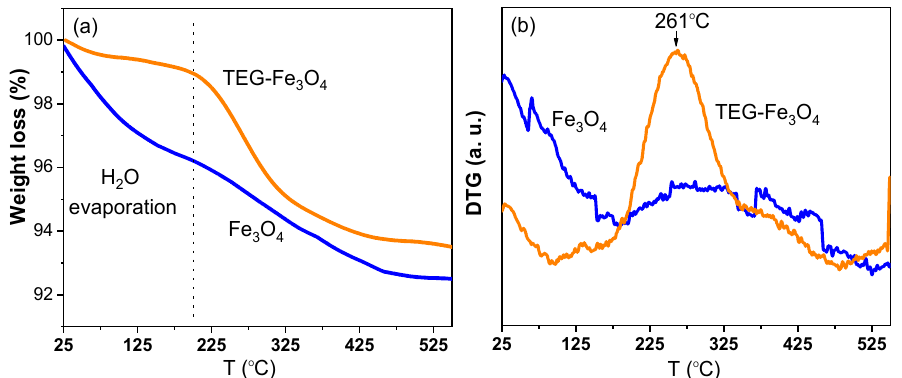
Fig. 3. The (a) TGA and (b) DTGA curves of Fe